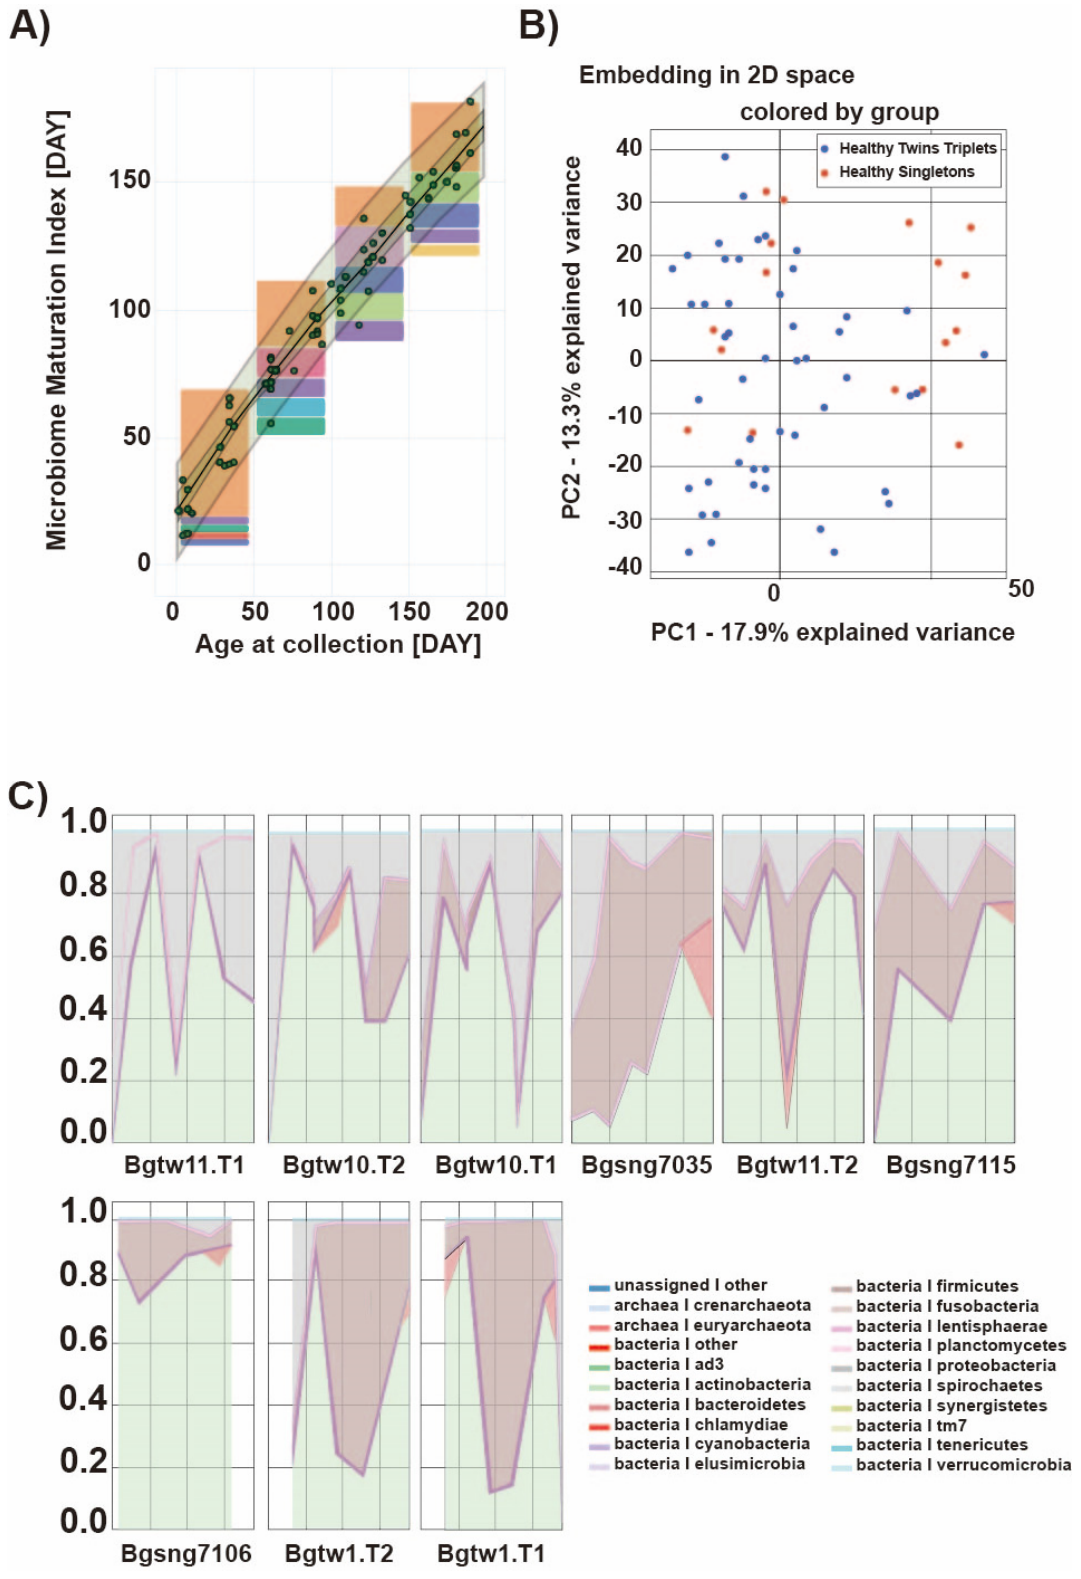
Figure 5. Output figures depicting the ( A ) important features for time trajectory, ( B ) PCA in 2D, and ( C ) dense longitudinal data corresponding to abundance generated using the human gut dataset found in Microbiome Toolbox.